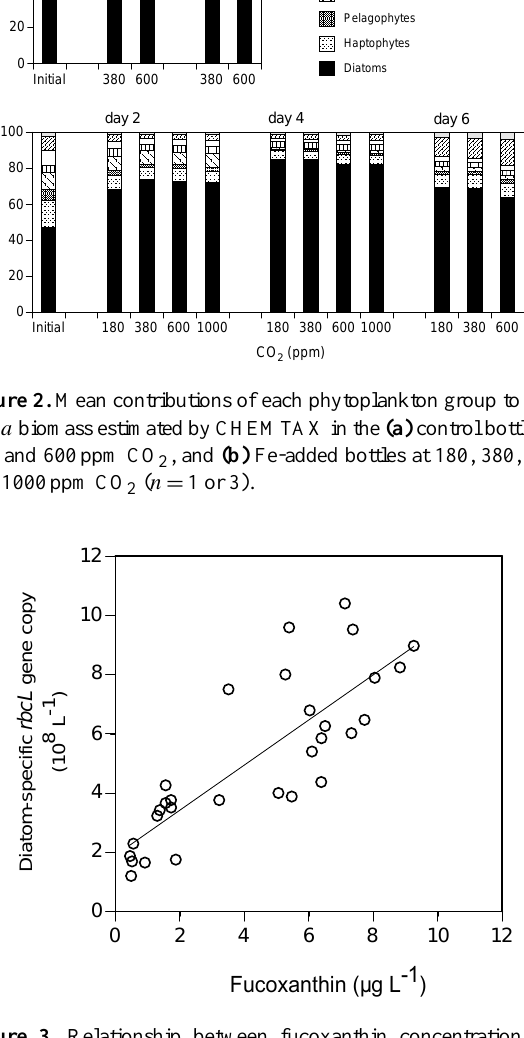
Figure 3. Relationship between fucoxanthin concentration and diatom-specific rbcL copy number ( y = 7 . 62 × 10 8 x + 1 . 90 × 10 8 , r 2 = 0 . 677, p <0.001, n =